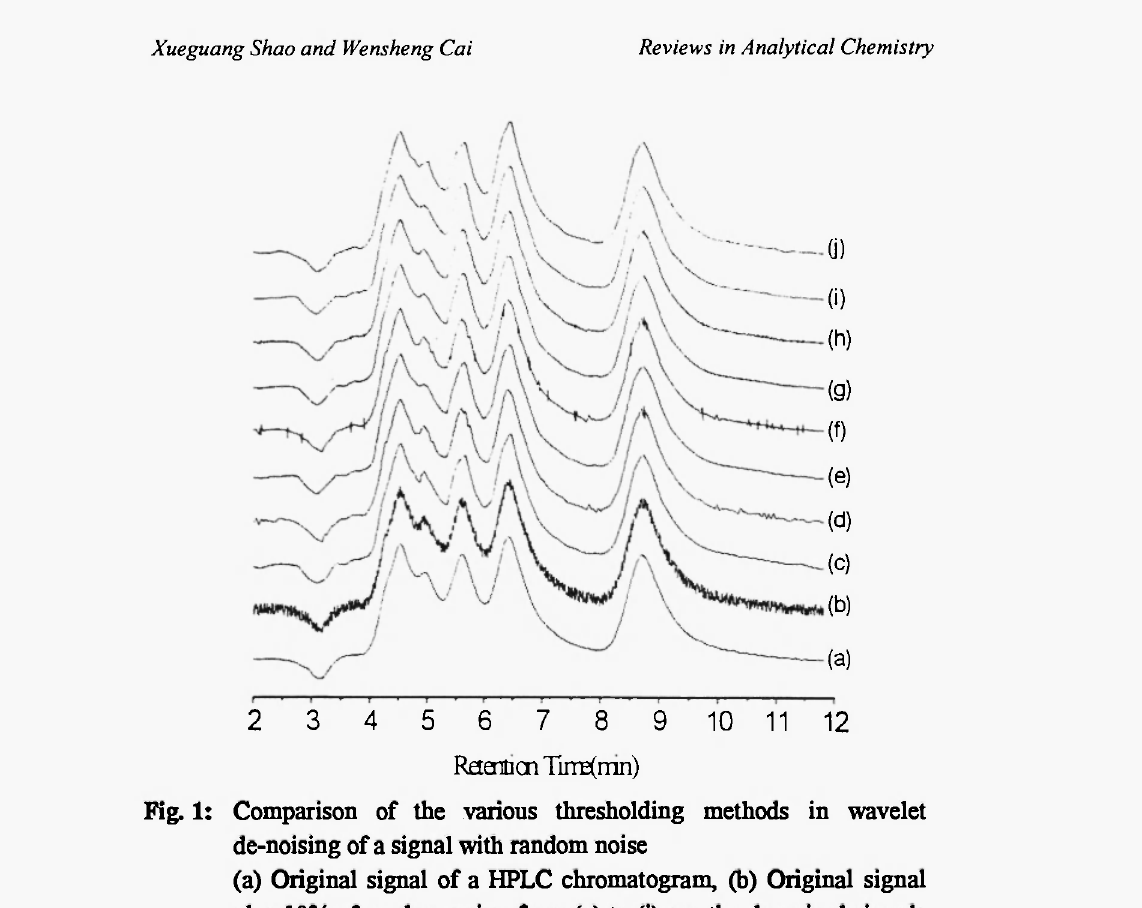
Fig. 1: Comparison of the various thresholding methods in wavelet de-noising of a signal with random noise (a) Original signal of a HPLC chromatogram, (b) Original signal plus 10% of random noise, from (c) to (j) are the de-noised signals by (c) hard thresholding with the threshold being 2.0% of the maximal wavelet coefficients; (d) SURE; (e) VISU with hard thresholding; (f) MINMAX; (g) Soft thresholding with the threshold being 1.0% of the maximal wavelet coefficients; (h) HYBRID; (i) VISU with soft thresholding; 0") smoothing with the first four discrete details being set to